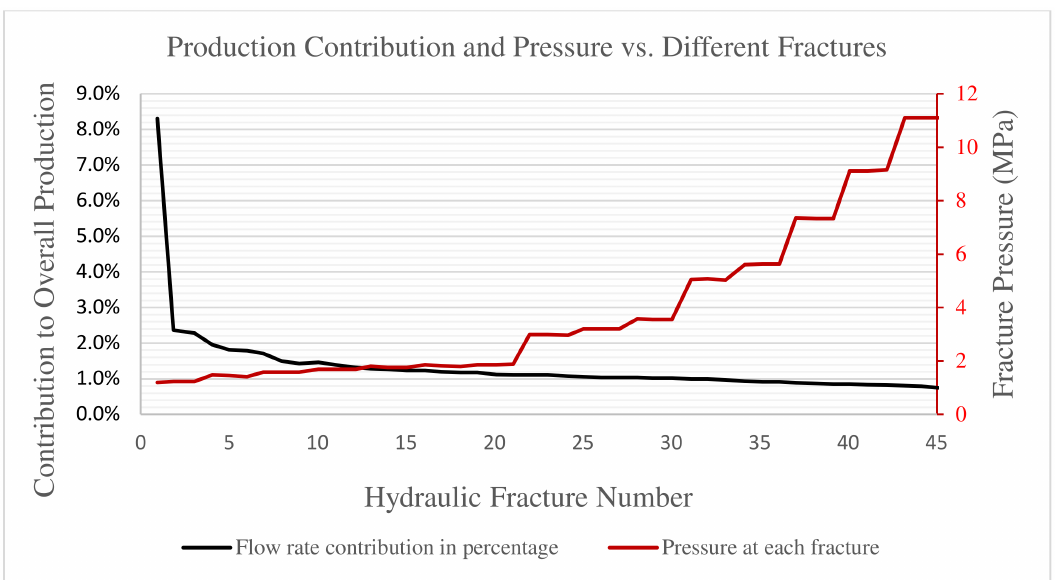
Figure 15. Pressure distribution and production contribution at each hydraulic fracture in the tilt- down well